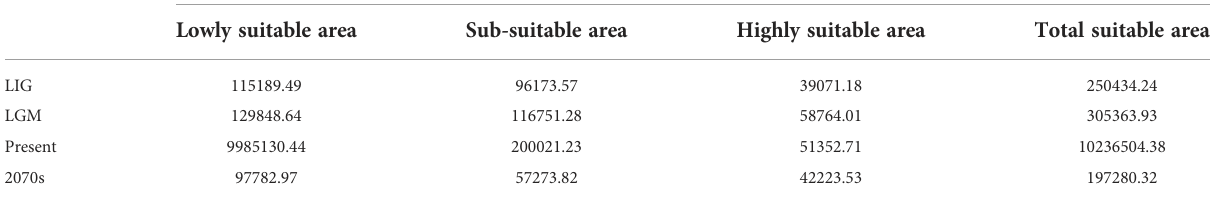
TABLE 4 Prediction of potential suitable distribution areas of H. lichiangensis in four